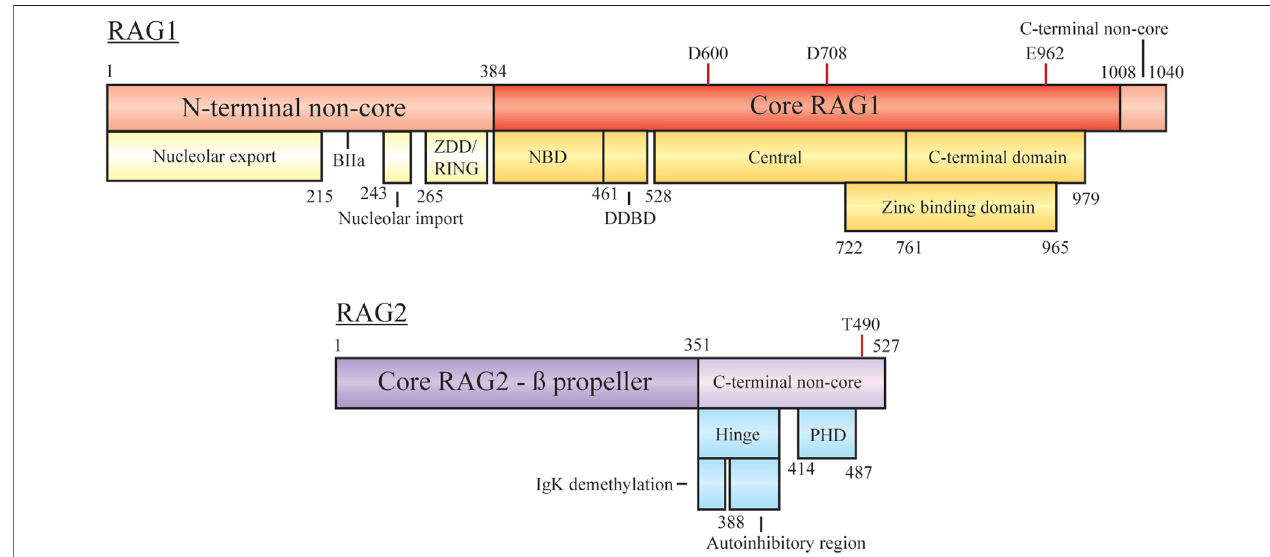
FIGURE 2 | Domain organization of RAG1 and RAG2, with minimal core regions shaded darker. Subdomains/functional regions are noted below each region. Residues involved in RAG1 catalytic activity and RAG2 degradation are highlighted. Abbreviations: ZDD, zinc dimerization domain; RING, really interesting new gene; NBD, nonamer binding domain; DDBD, dimerization and DNA-binding domain; PHD, plant homeodomain.